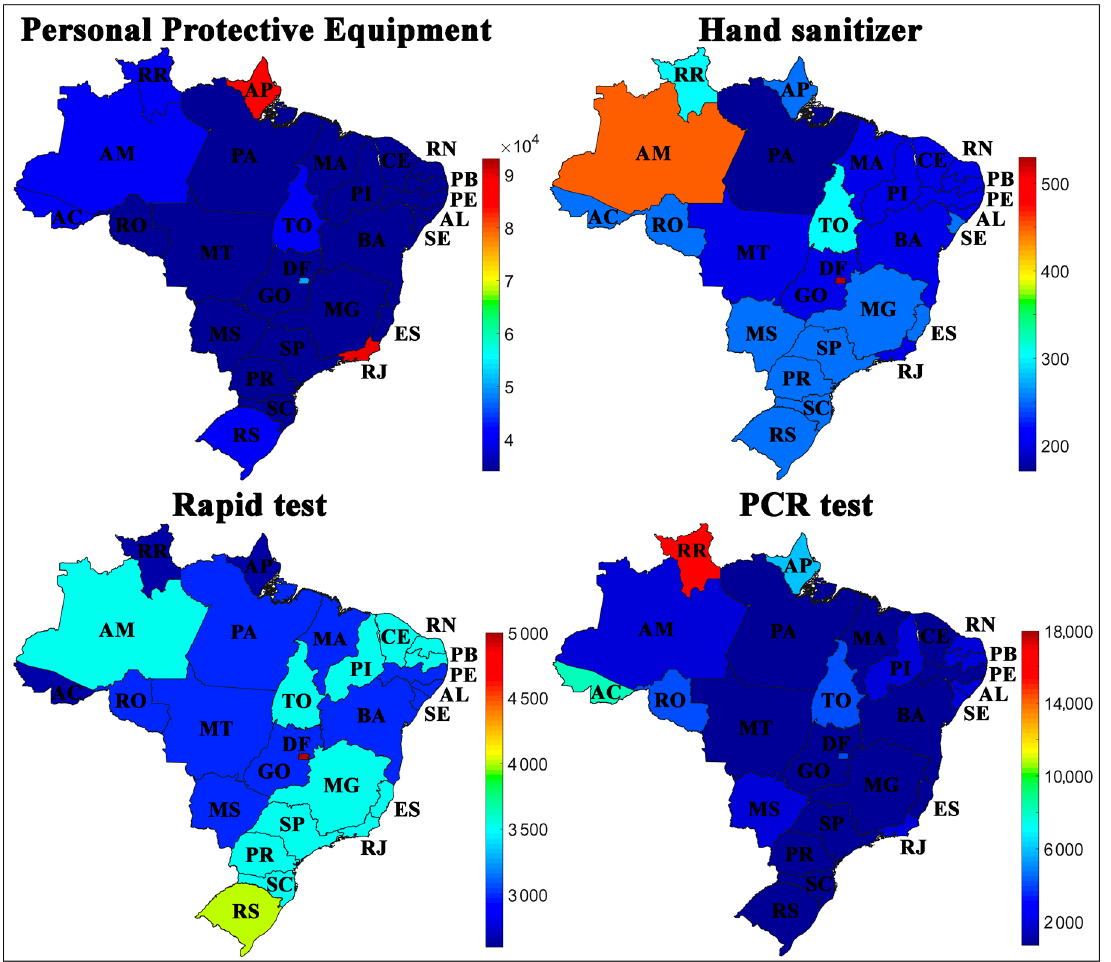
Figure 4. Geographical distribution of Personal Protective Equipment (PPE), hand sanitizer, rapid tests, and PCR tests available to Brazilian states per 100,000